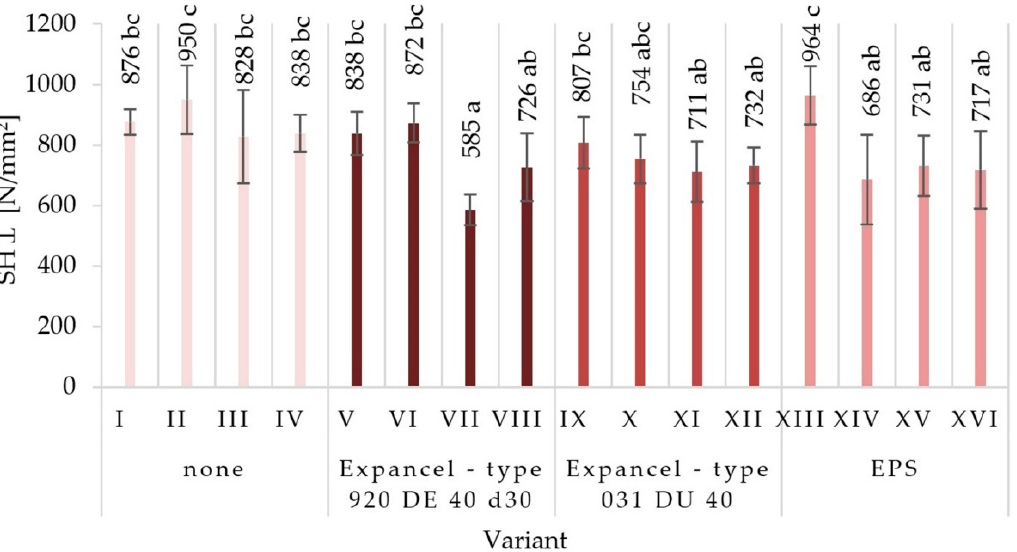
Figure 7. Screw-holding capacity perpendicular to the surface (SH Ʇ ) of the particleboards pro- duced (means and standard deviation, a, b, c, (…). Homogeneous groups were determined by the Tukey test; different letters denote a significant difference; means followed by the same letter do not statistically differ from each other).